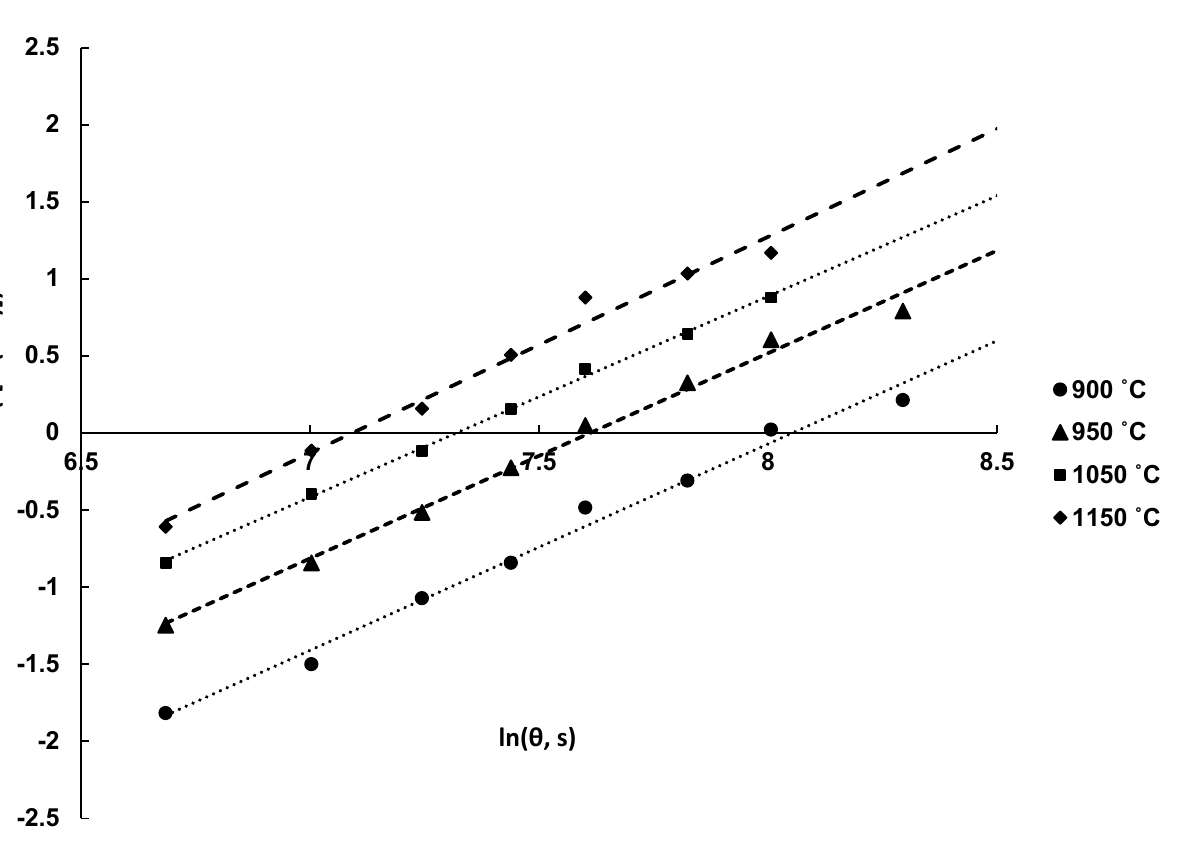
Figure 5. Application of the MVR model to the reduction of barite compacted samples (zone A; see Figure 1) by brown coal in an oxygen-free environment.